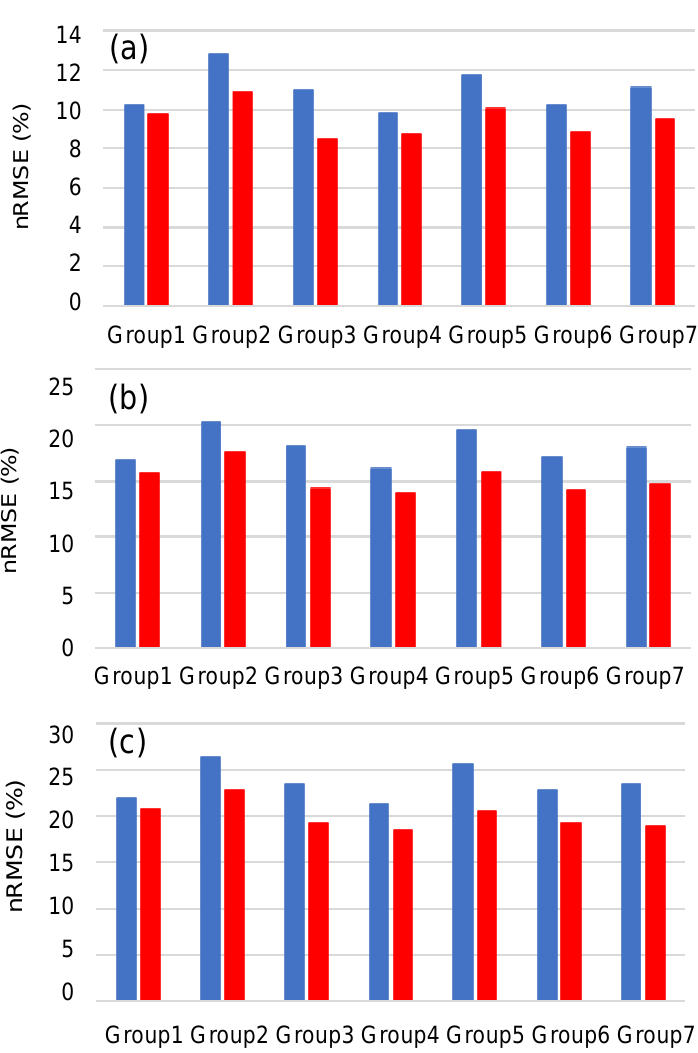
Figure 8. nRMSE bar plot comparing the VAR and ARIMA models for ( a ) 1 h, ( b ) 2 h, and ( c ) 3 h advance forecasting, respectively. Blue and red indicate error statistics obtained from the VAR and ARIMA forecasting models, respectively.